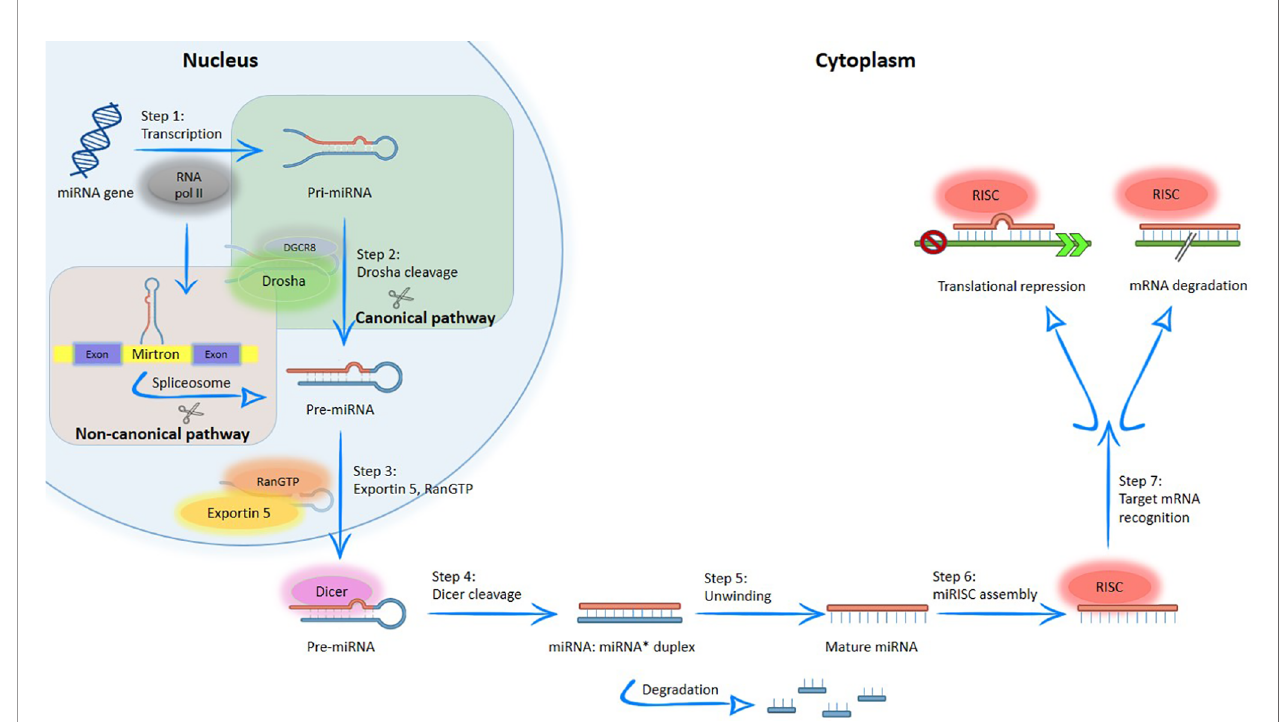
FIGURE 2 | Simpli fi ed overview of the canonical and non-canonical miRNA biogenesis pathways. MiRNA generated by canonical pathway is transcribed by RNA polymerase II to a primary transcript called pre-miRNA. Subsequently, this structure is processed into the nucleus by DGCR8/Drosha complex; producing the pre- miRNA, which is exported to the cytoplasm by exportin-5. In the cytoplasm, pre-miRNA is cleaved by RNase III endonuclease (Dicer protein), resulting in a double stranded miRNA, which contains the mature miRNA. After, double strand is separated by helicases and create the mature miRNA; on the contrary, in non-canonical pathways, miRNA located within of mirtrons and are associated with spliceosome-dependent mechanisms. After, the mature miRNA produced by different pathways enters into the RISC complex and regulated genes through messenger RNA (mRNA) degradation and mRNA translation